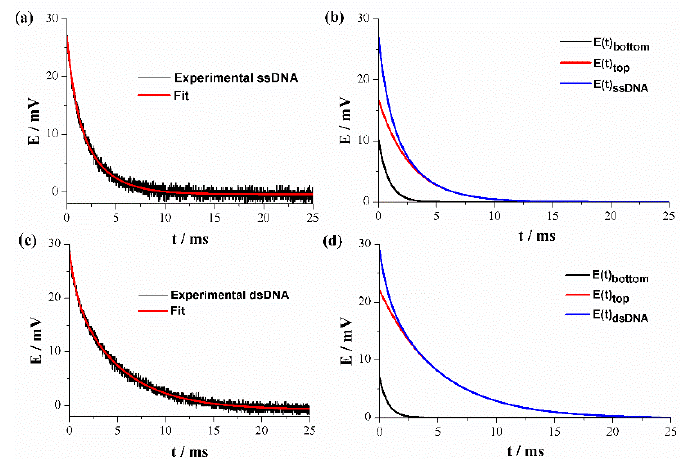
Figure 4. Potential step transient in ssDNA ( a , b ) and dsDNA ( c , d ) with the diode rectifier system.